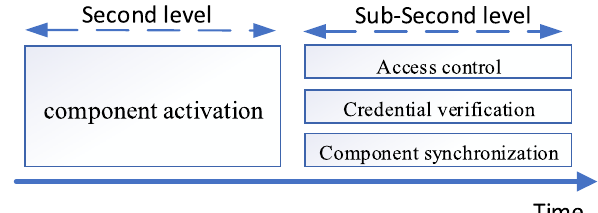
Figure 8. Schematic diagram of the various overhead of